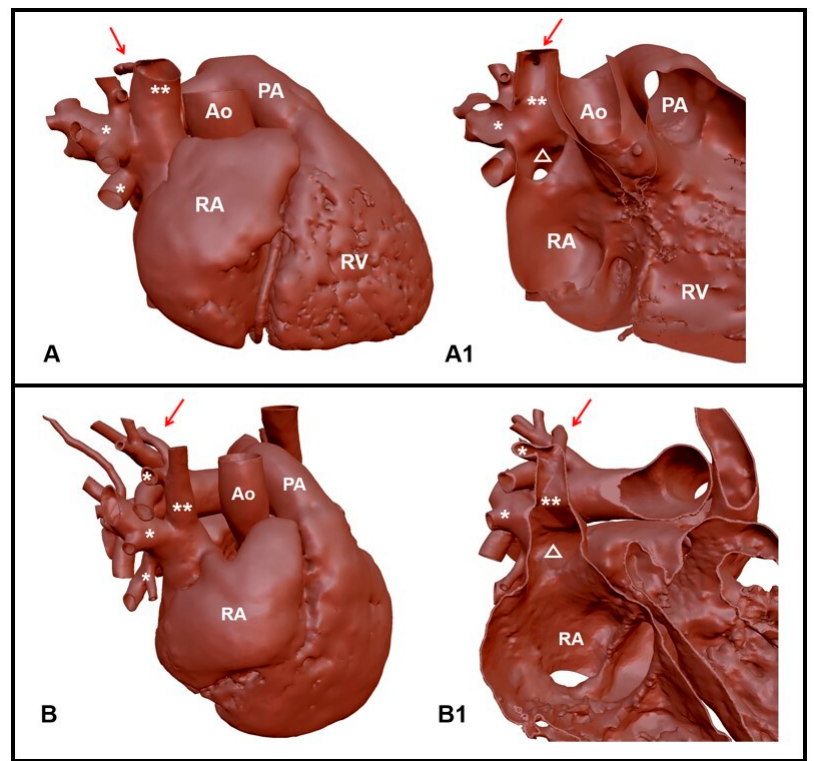
Figure 2. Three-dimensional reconstruction of two cases of partial anomalous pulmonary venous return in superior vena cava; the red arrow indicates the azygos vein. ( A , A1 ) Case 1. ( A ) The anomalous pulmonary veins are displaced closer to the atrio-caval junction; ( A1 ) coronal section; the sinus venosus defect is indicated by the white triangle. ( B , B1 ) Case 2. ( B ) The most cranial anomalous pulmonary vein drains together with the azygos vein; ( B1 ) coronal section; the sinus venosus defect is indicated by the white triangle. Ao: aorta; PA: pulmonary artery; RA: right atrium; RV: Right Ventricle; *: anomalous pulmonary veins; **: superior vena